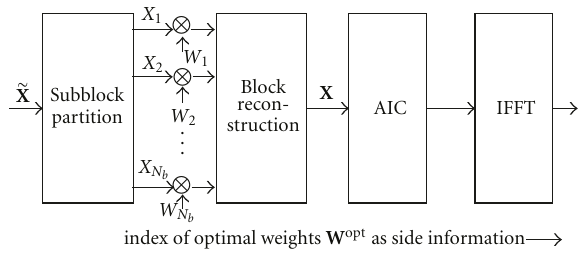
Figure 2: PTS-AIC transmission